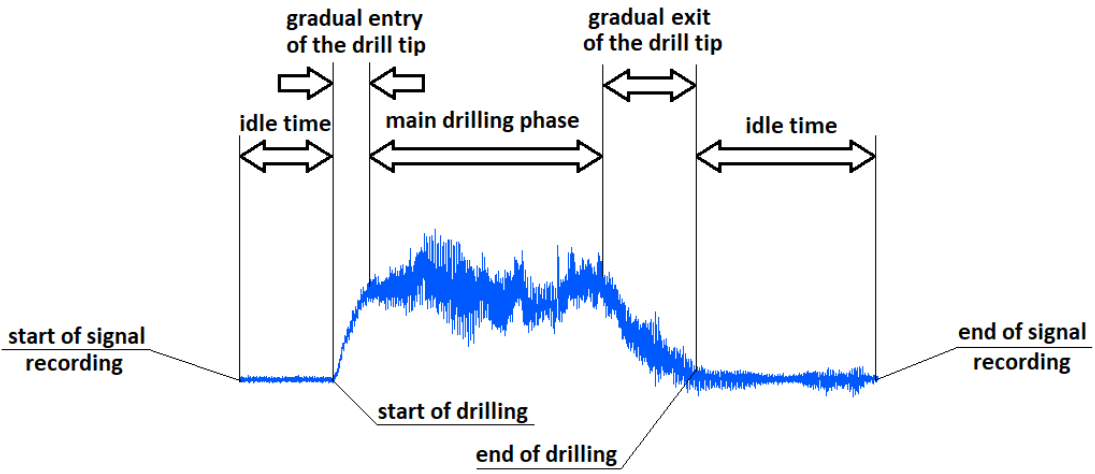
Figure 5. Typical changes in the feed force signal recorded during the